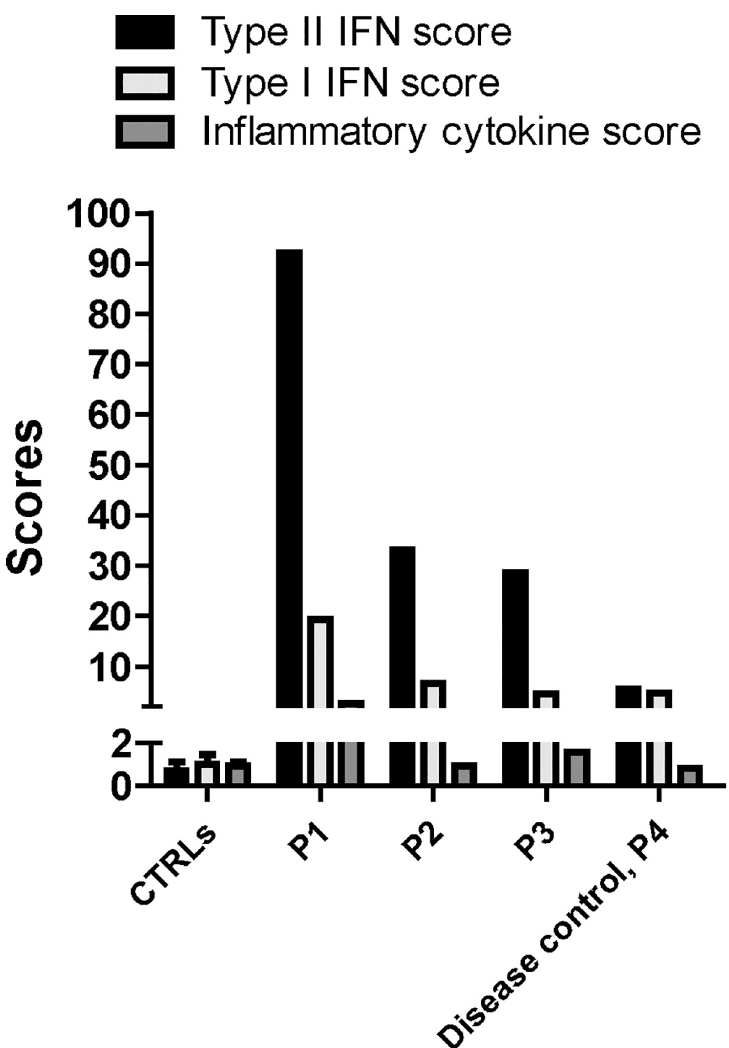
material and methods